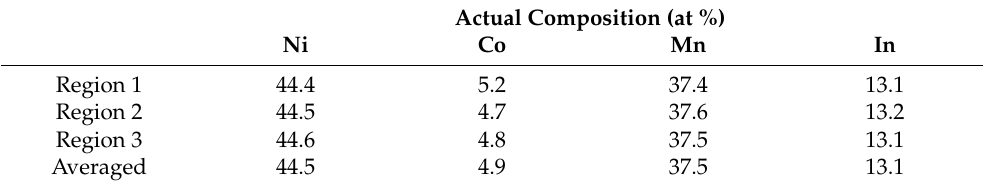
Table 1. Experimentally determined compositions (at %) by EDS for the directionally solidified alloy. Actual Composition (at %) Ni Co Mn In Region 1 44.4 5.2 37.4 Region